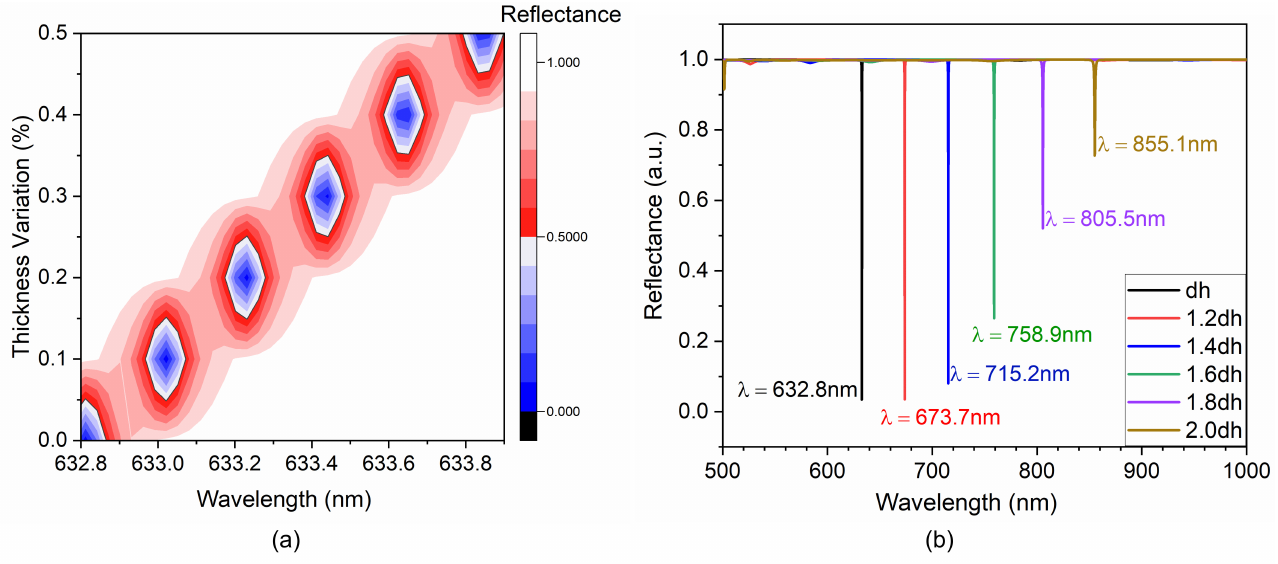
Figure 3. The impact of varying DAST material width on filtered wavelength for a constant incidence angle of 45.07: ◦ ( a ) for 0.5% thickness variation; and ( b ) for 100% thickness